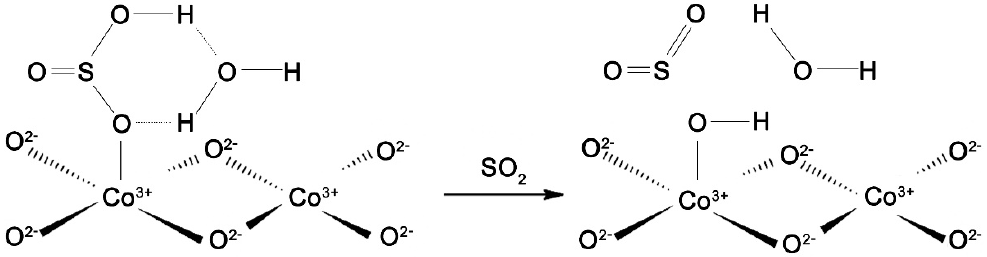
Figure 12. Decomposition of sulfites on Co 3 O 4 in the presence of water.